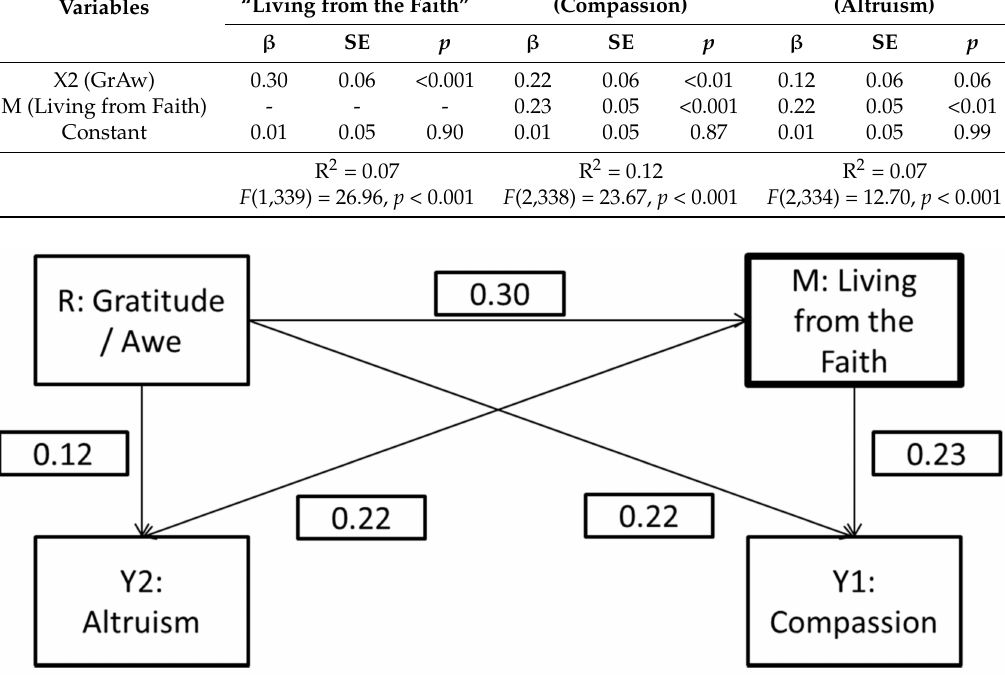
Figure 4. Mediation model (direct model) for Compassion (Y1) and Altruism (Y2) mediated by “Living from the Faith” (M) and Gratitude/Awe as a regressor (R). Scores are β